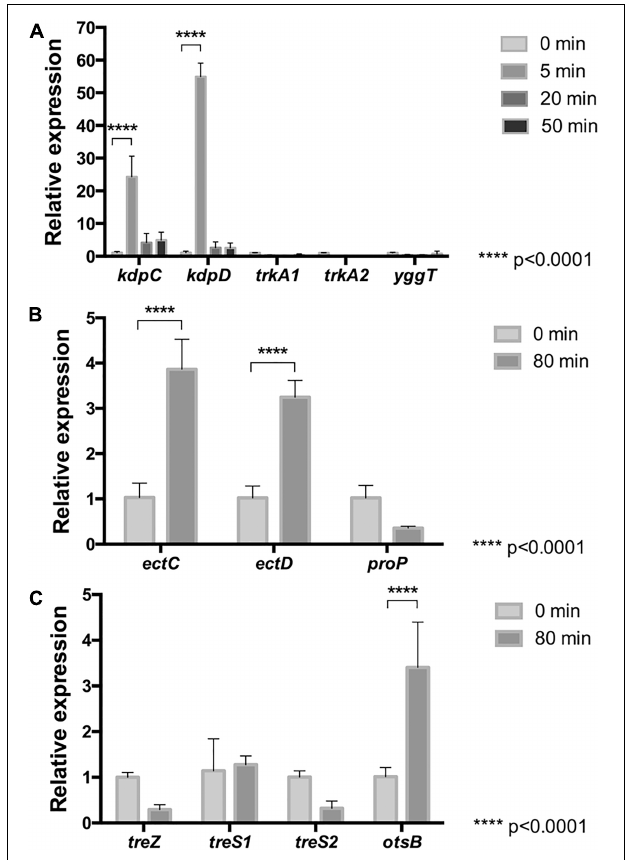
FIGURE 1 | Relative mRNA levels of osmotic stress related genes in L. ferriphilum DSM 14647. Relative expression of K + transporter genes was evaluated (A) in cells treated with 100 mM NaCl for 5, 20, and 50 min. Relative expression of genes for biosynthesis of (hydroxy)ectoine (B) and trehalose (C) was evaluated in cells treated with 100 mM NaCl for 0 and 80 min. Data were normalized by the 16S rRNA. Data represent the average of three independent experiments (bars indicate the value range). Statistical analysis was carried out by ANOVA and t